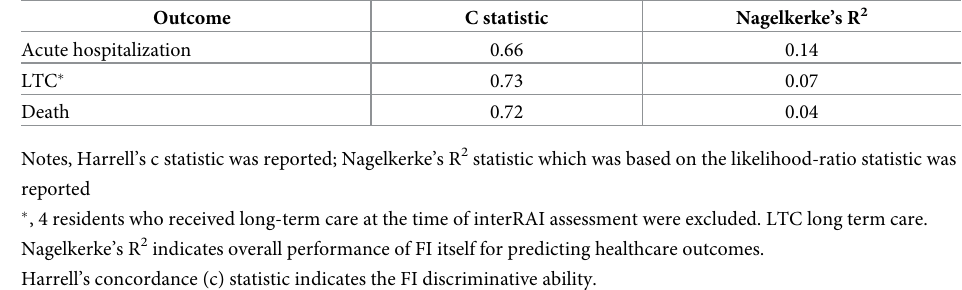
Table 3. Discrimination and overall performance of frailty index categories for predicting healthcare